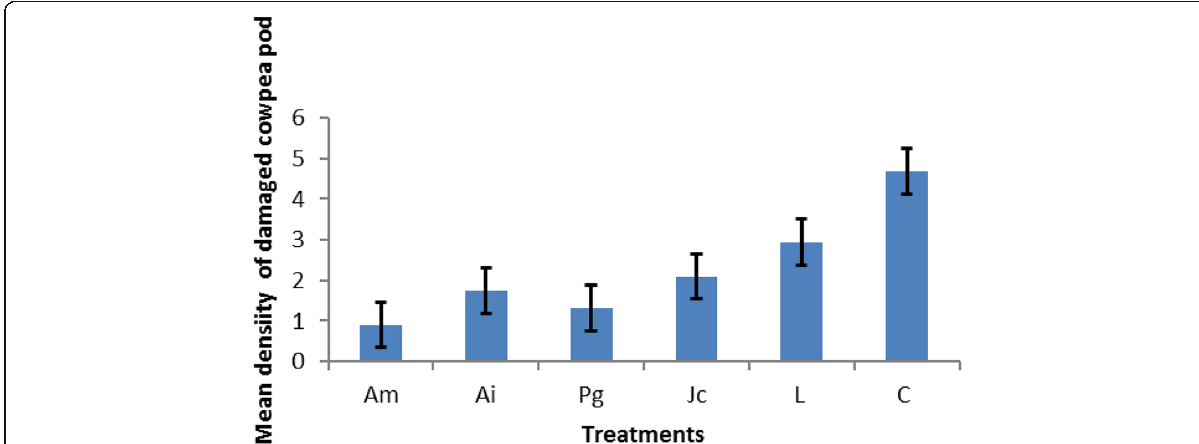
Fig. 3 Effect of treatments on the number of damaged cowpea pod. Mean values are the number damage cowpea pod observed from different plots treated with different botanicals. Am, plot treated with Annona muricata ; Ai, plot treated with Azadirachta indica ; Pg, plot treated with Piper guineense ; Jc, plot treated with Jatropha curcas ; L, lambdacyhalothrin; C, control (no